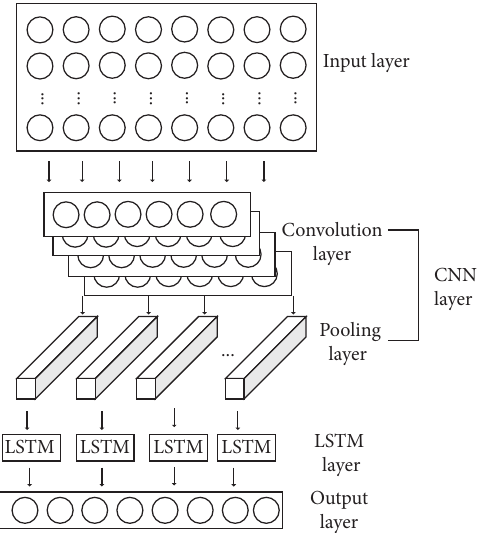
Figure 2: Architecture of LSTM memory cell.